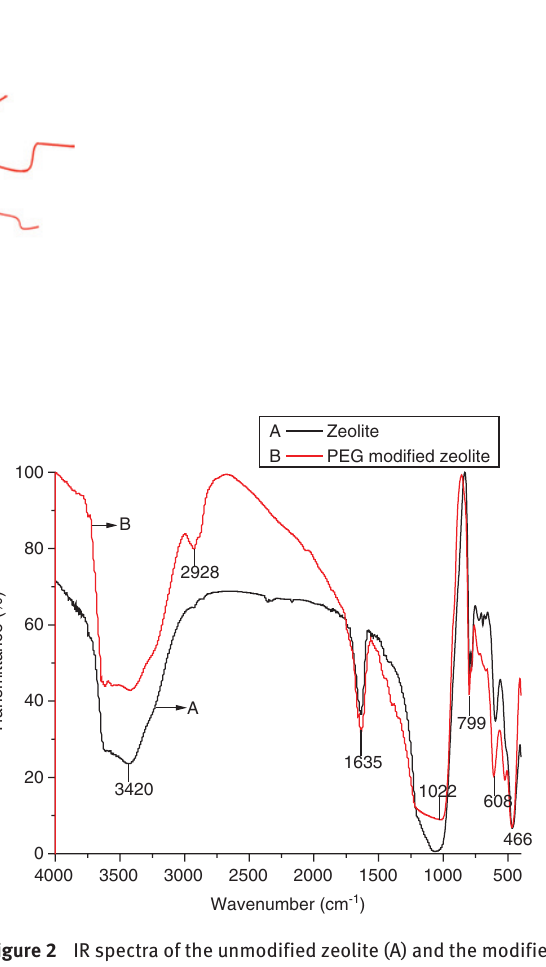
Figure 2 IR spectra of the unmodified zeolite (A) and the modified zeolite (B).